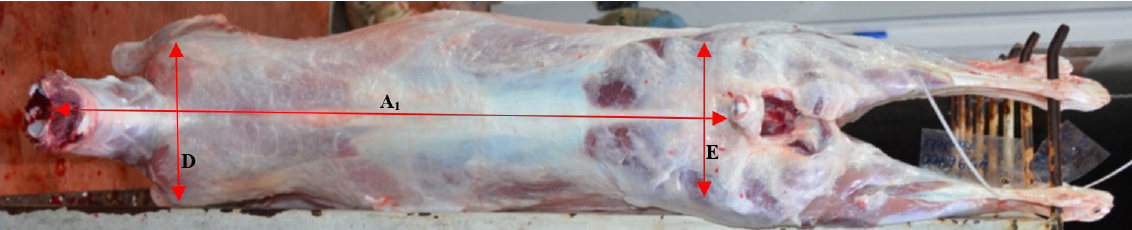
Figure 2. Carcass measurements ( A 2 : external carcass length, D : shoulder width, E : rump width).